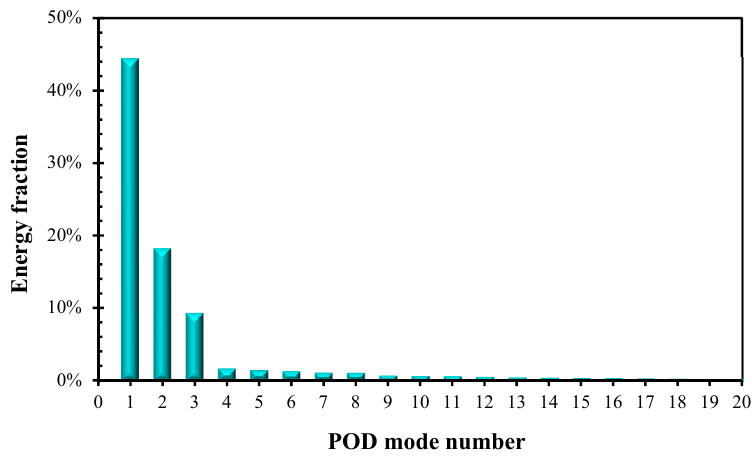
Figure 13. Energy fraction captured by first 20 Proper Orthogonal Decomposition (POD) modes.